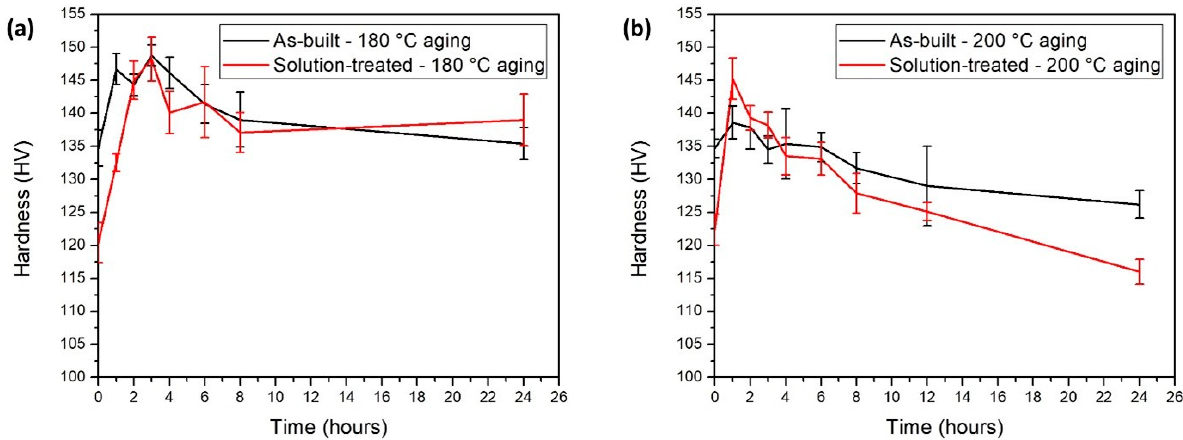
Figure 6. Aging curves of as-built and solution treated samples performed at ( a ) 180 ◦ C and ( b ) 200 ◦